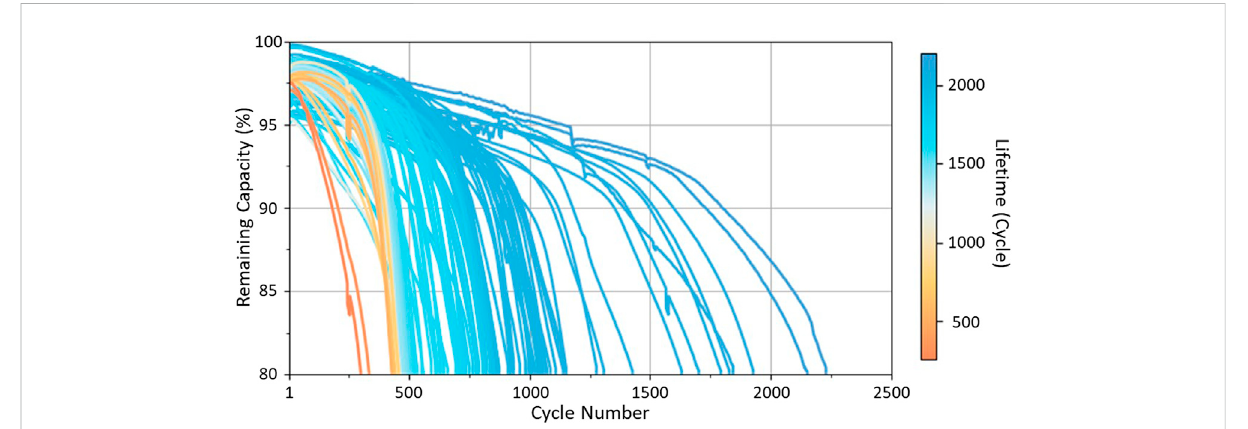
FIGURE 1 Battery capacity fade curves of the dataset. The lifetime ranges from 300 to 2300